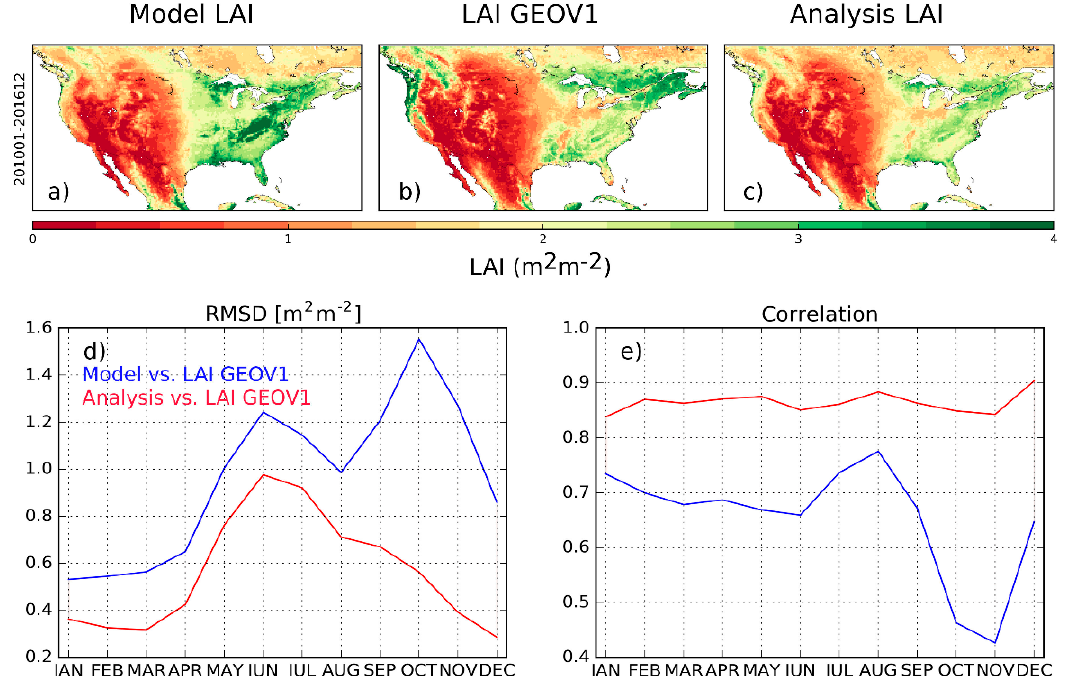
Figure 3. Top row; leaf area index from ( a ) the model, ( b ) the observations, and ( c ) the analysis averaged over the 2010–2016 time period. Bottom row: seasonal ( d ) root mean square difference (RMSD) and ( e ) correlation values between leaf area index (LAI) from the model (in blue), the analysis (in red) and GEOV1 LAI estimates from the Copernicus Global Land Service project from 2010 to 2016.